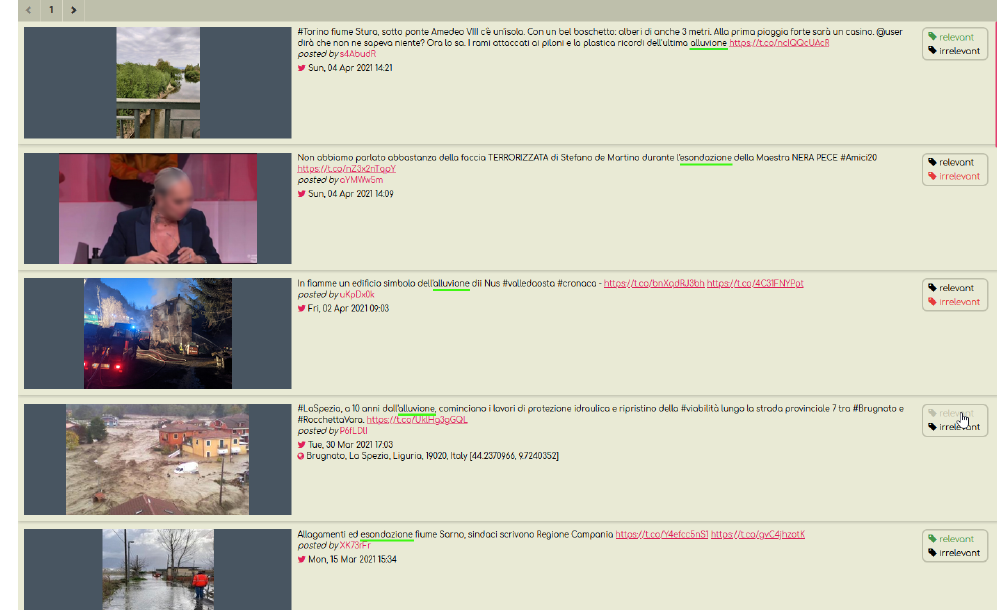
Figure 4. Screenshot of the annotation